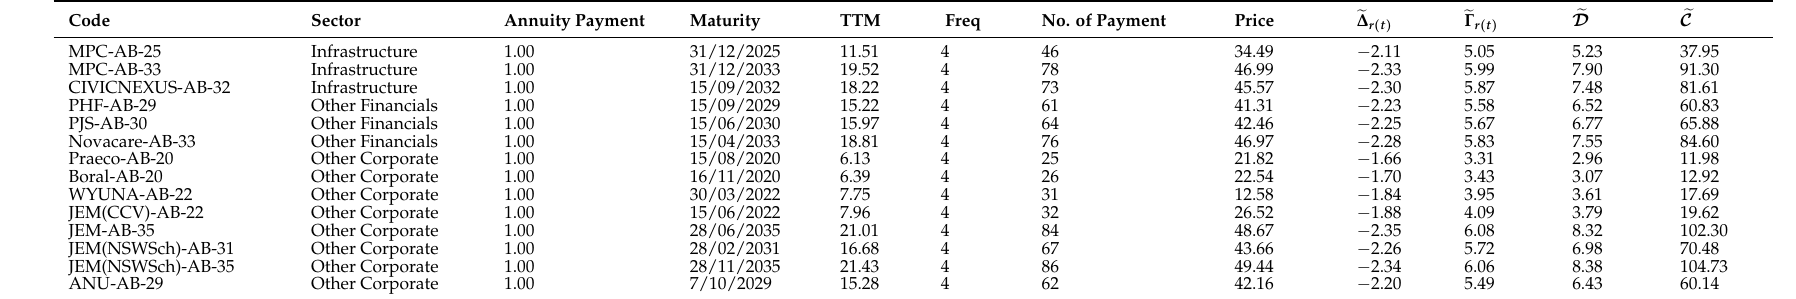
Table 10. These are hypothetical annuity bonds with maturities corresponding to index linked bonds available on FIIG. We do not include inflation in the analysis so we have used these as hypothetical annuity bonds with quarterly frequency. Terms to maturity are longer than for the Waratah annuity bonds. We do not adjust pricing for credit risk.